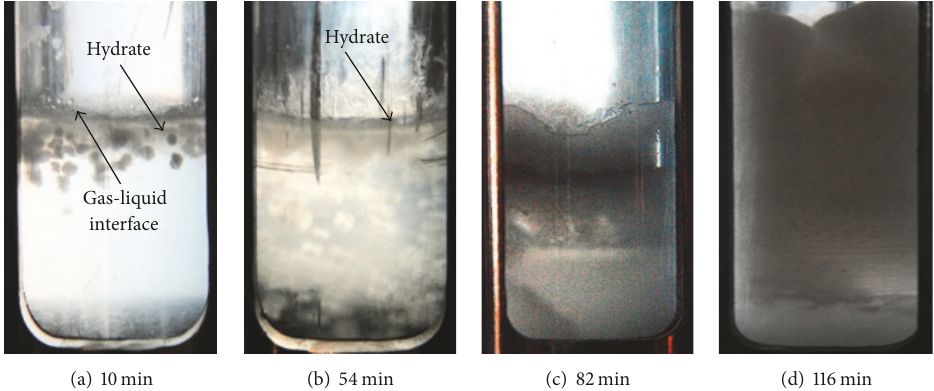
Figure 5: The process of mine gas hydrate formation in NaCl-SDS system.